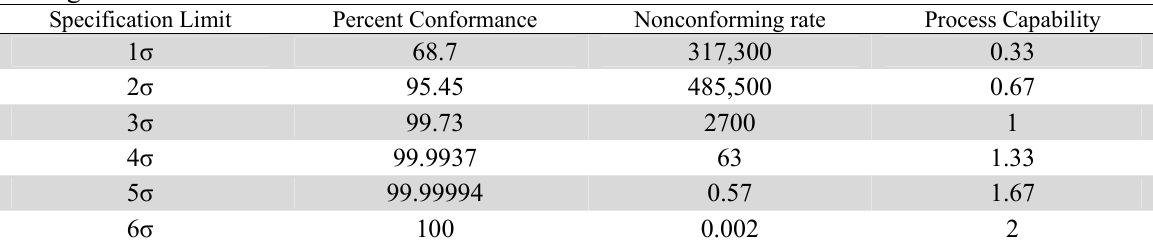
Six Sigma Chart Specification